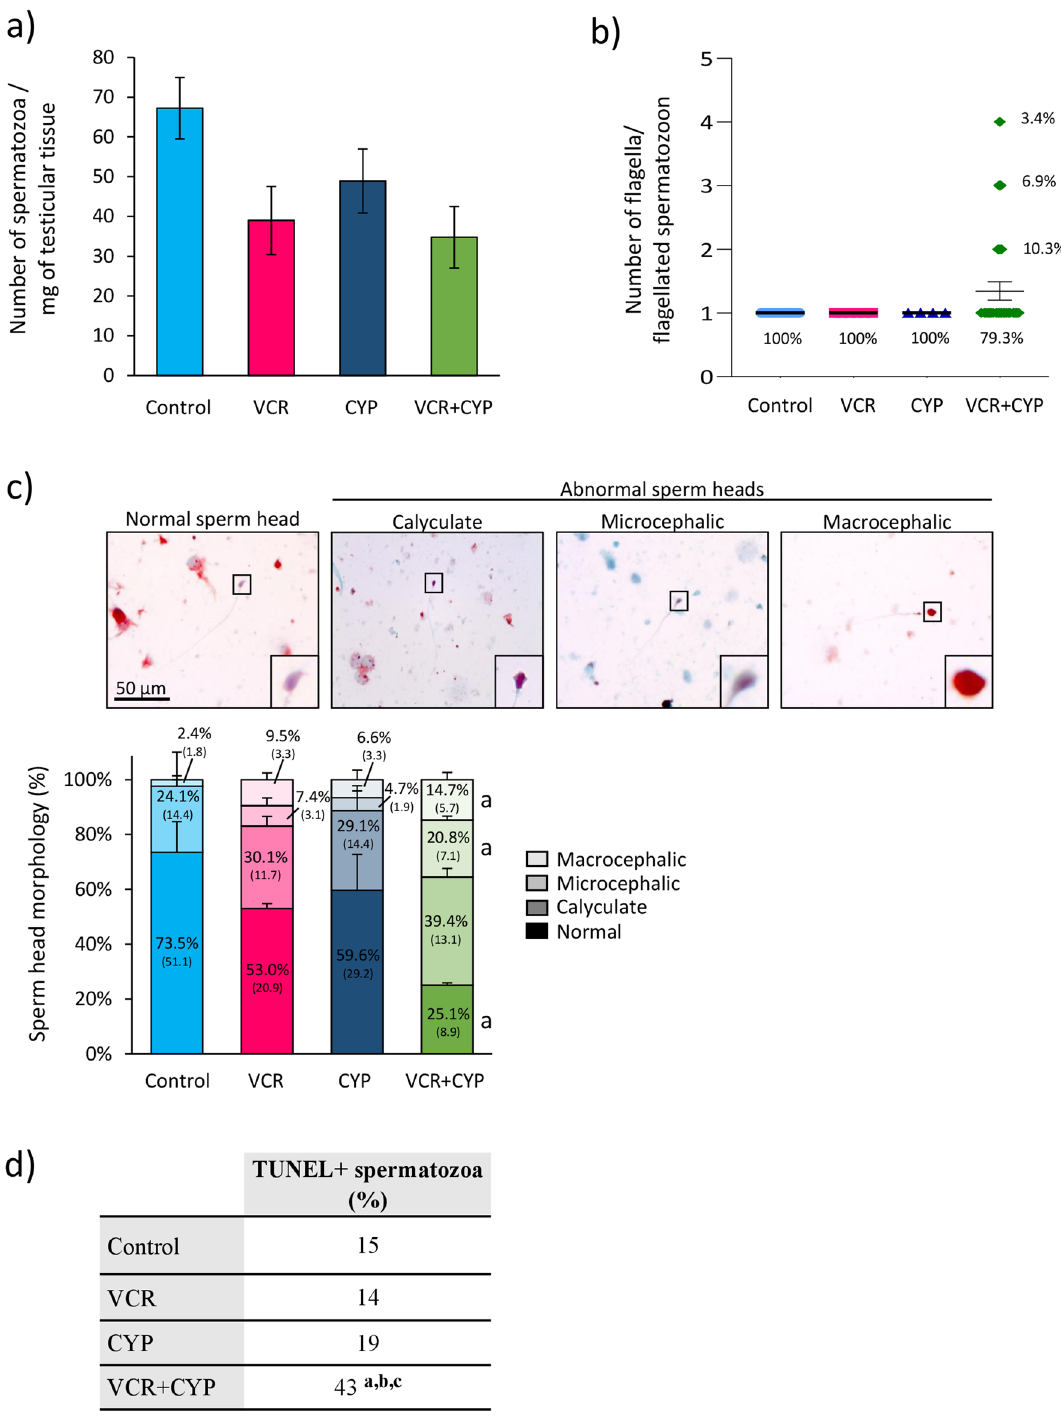
Figure 5. Impact of chemotherapy prepubertal exposure on in vitro produced spermatozoa. ( a ) Histogram representing the mean number of spermatozoa per milligram of tissue produced after in vitro maturation of testicular tissues from mice exposed to monochemotherapy (VCR or CYP), polychemotherapy (VCR+CYP) or unexposed (control) during the prepubertal period. ( b ) Percentage of spermatozoa with one or multiple (2, 3 or 4) flagella among the flagellated spermatozoa recovered from testicular tissues of control, VCR, CYP or VCR+CYP-treated mice after 30 days of culture. ( c ) Histogram representing the proportion of in vitro produced spermatozoa with normal or abnormal heads in testicular tissues exposed to VCR, CYP, VCR+CYP or unexposed (control). Sperm heads were assigned to two categories based on morphological observations: normal (elongated and hook-shaped) and abnormal 33 . Abnormal heads included calyculate, microcephalic (small rounded head) and macrocephalic (large rounded head). The mean number of spermatozoa counted per milligram of tissue is indicated in brackets for each category of sperm head morphology. ( d ) Percentage of in vitro produced spermatozoa with fragmented DNA (TUNEL+) in testicular tissues from control, VCR, CYP or VCR+CYP-treated mice. For each condition, hundred spermatozoa were examined. The results are presented as means ± SEM with n = 6 pooled cultured testes per group. a P < 0.05 compared to control; b P < 0.05 compared to VCR and c P < 0.05 compared to